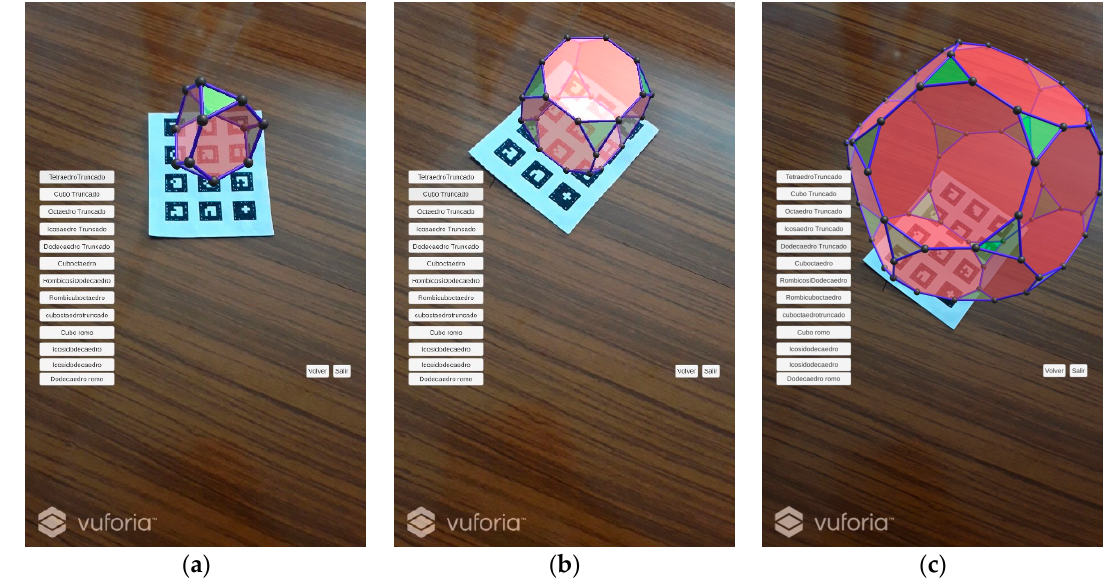
Figure 9. Images of several truncated polyhedra. ( a ) Truncated tetrahedron; ( b ) Truncated octahedron; ( c ) Truncated dodecahedron.